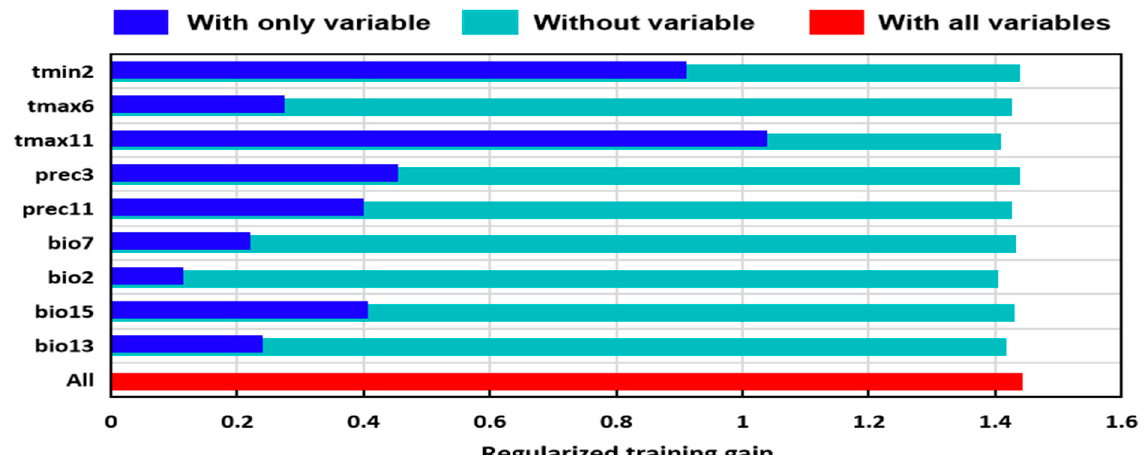
Figure 3. Percentage contribution of the nine variables. x -axis variables represent the minimum temperature in February (tmin-2), precipitation in March (prec-3), maximum temperature in November (tmax-11), maximum temperature in June (tmax-6), precipitation seasonality (bio-15), mean diurnal range (bio-2), precipitation in November (prec-11), precipitation of the wettest month (bio-13), temperature annual range (bio-7).